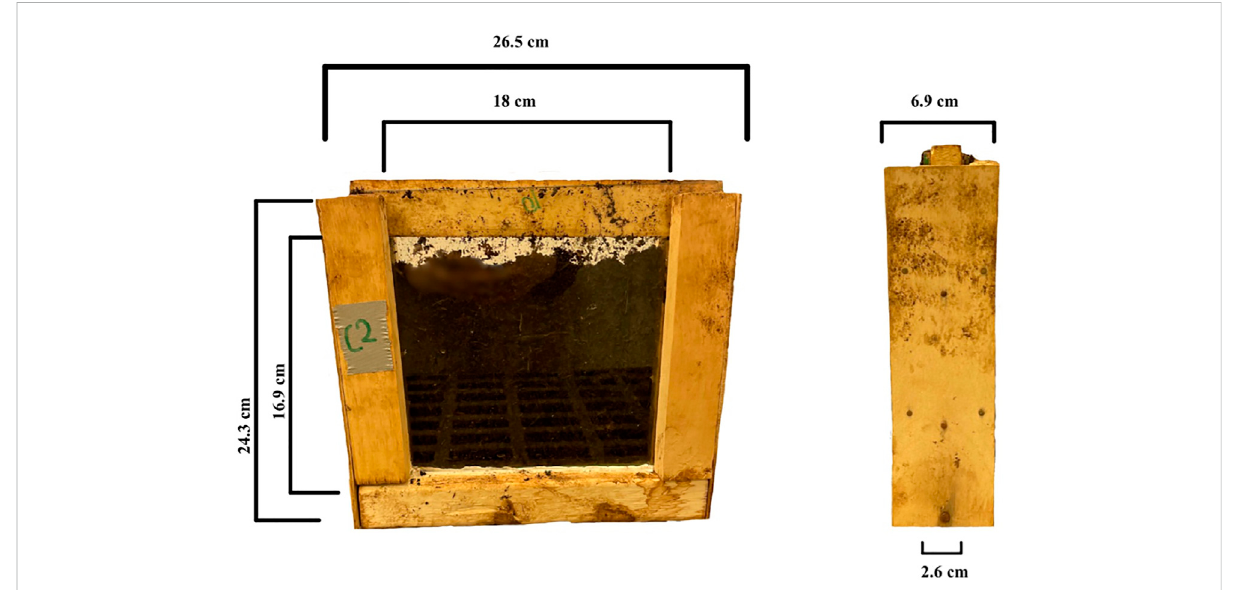
FIGURE 1 Thefrontfaceofanant-farmstyleenclosureusedforthisexperiment.Acamerafocusedonthefrontfaceandtheback faceofeachenclosure, and the narrow internal width (2.6 cm) allowed constant visibility within each